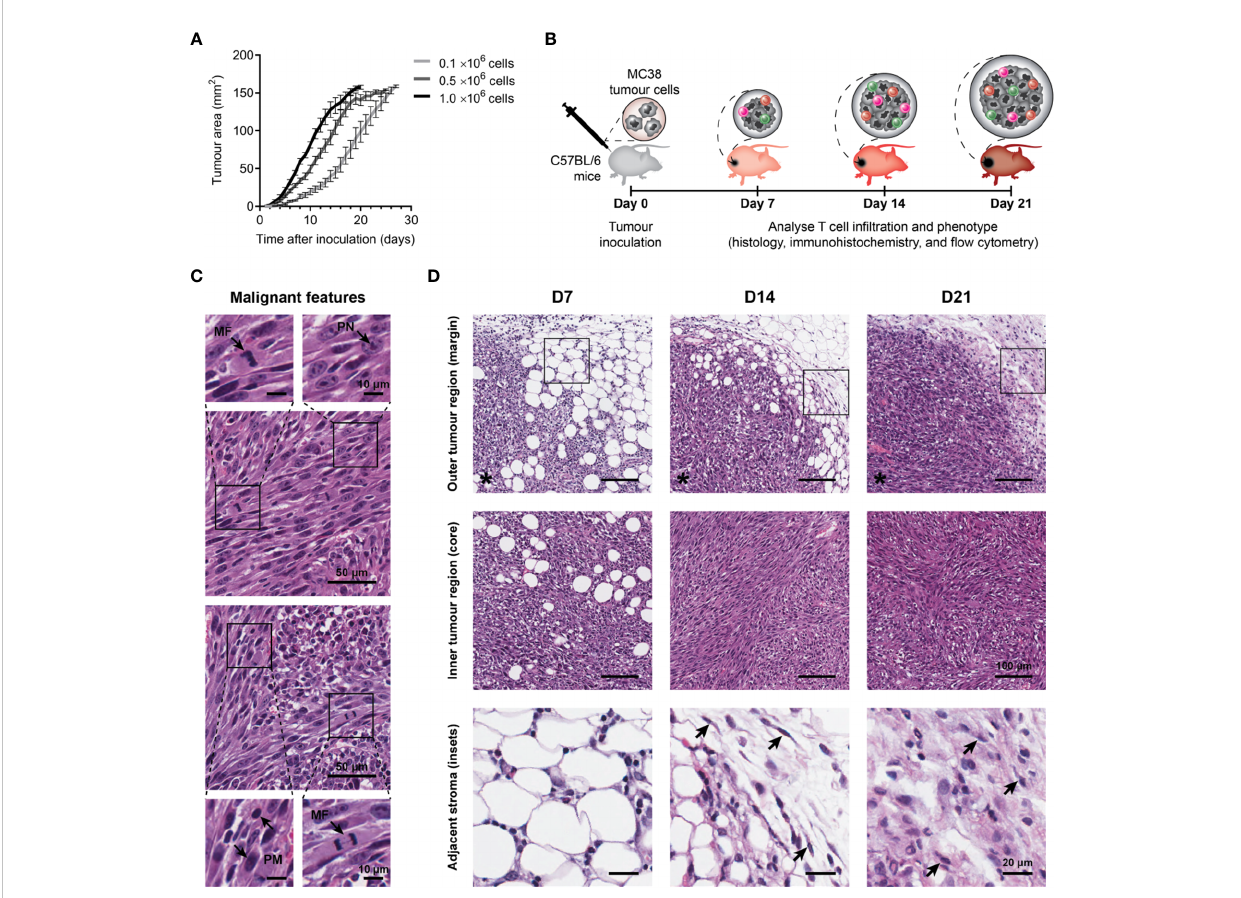
FIGURE 1 Growth kinetics and histological features of MC38 tumours. (A) Growth kinetics of MC38 tumours in vivo . Syngeneic C57BL/6 mice were inoculated with indicated numbers of MC38 cells by subcutaneous injection at the right hind fl ank (n = 10 per group). Growth curves depict the mean and standard error of the mean (SEM, error bars). (B) Study design to characterise T cell in fi ltration. MC38 tumours were resected 7-, 14- and 21-days post-inoculation and processed for histology, immunohistochemistry, or fl ow cytometry. (C) Histological features in haematoxylin and eosin (H&E) stained MC38 tumour sections. Arrows indicate characteristics of high-grade neoplasms, including hyperchromatic nuclei containing multiple, prominent nucleoli (PN; arrow, top left inset), mitotic fi gures (MF; arrows, bottom left and top right insets) and pleomorphism (PM; arrows, bottom right inset). (D) H&E images depicting structural changes in the outer (top row) and inner (middle row) regions of MC38 tumours during outgrowth (D7, D14 and D21) and high magni fi cation images of adjacent stroma at the tumour margin (bottom row, ROI shown in top row). Arrows indicate stromal cells with morphological features typical of normal fi broblasts in D14 tumours (thin, wavy, spindle-shaped cells), and cancer-associated fi broblasts (CAFs) in D21 tumours (large cells with plump nuclei). Asterisks (*) denote the side of the tumour in images of the tumour margin. Scale bar dimensions are shown at the right of each row (10, 20, 50 and 100 m